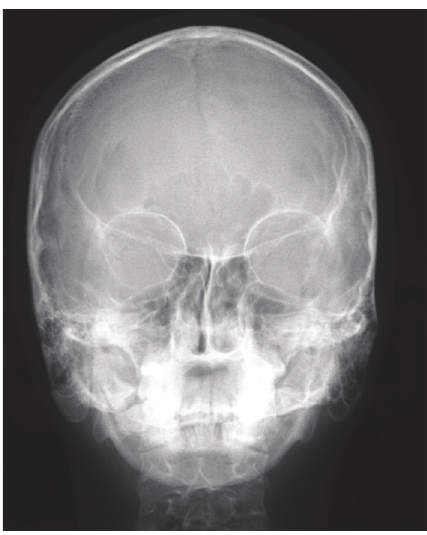
Figure 6: PA view reveals no significant asymmetry.